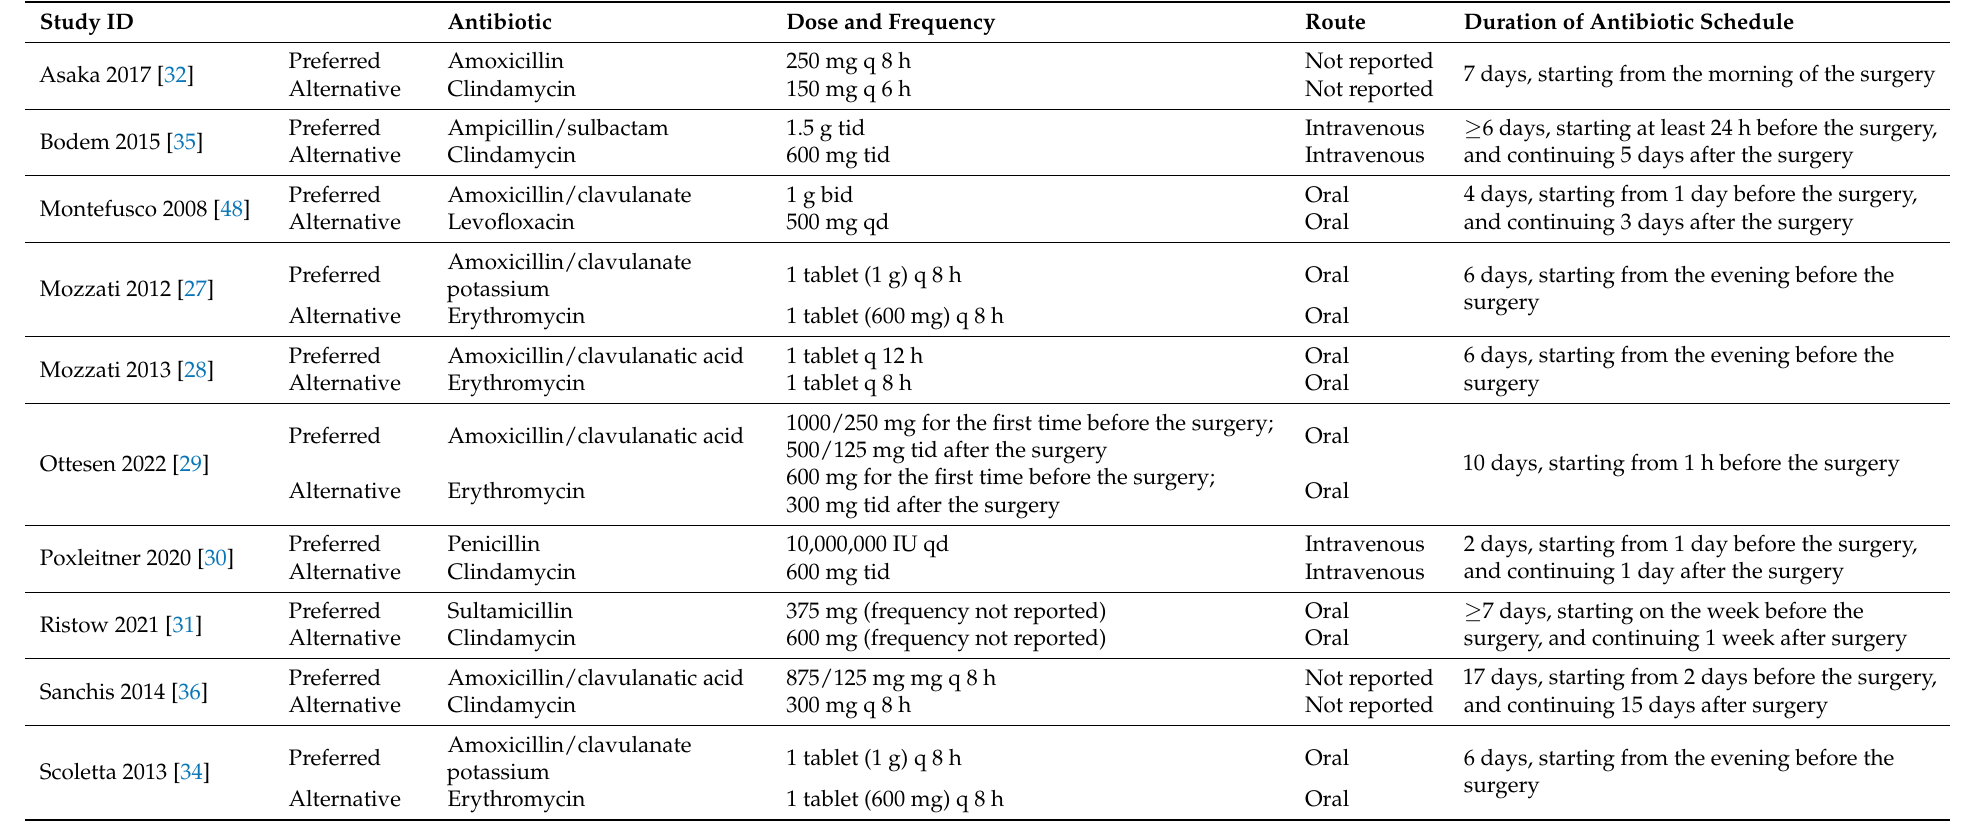
Table 6. Standard antibiotic schedules reported in included primary